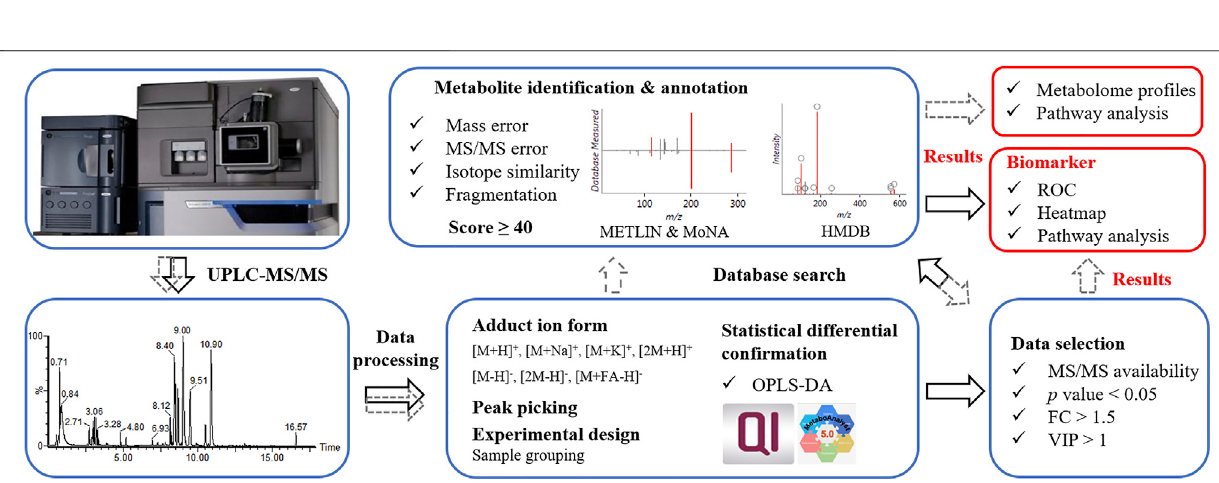
Frontiers in Pharmacology |